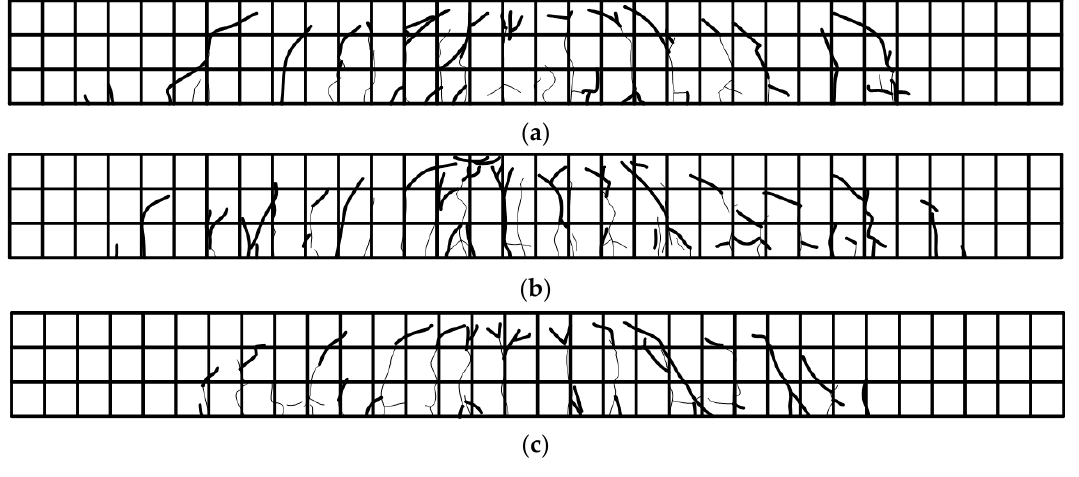
Figure 13. Crack map: ( a ) E-OX-1-40-67%; ( b ) E-OX-1-40-80%; ( c ) E-OX-1-40-93%.